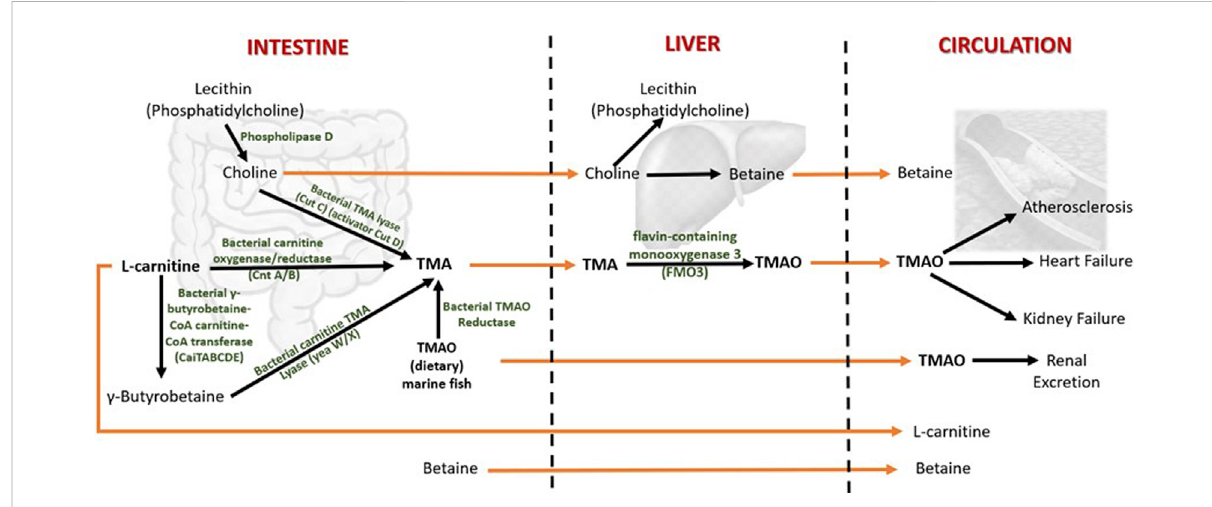
FIGURE 2 Metabolism of TMAO and betaine in humans. Both TMAO and betaine are procured from the diet and synthesized endogenously from the dietary constituents. The gut microbiota plays a central role in TMAO biosynthesis and thereby contributes signi fi cantly to plasma TMAO levels. TMA (trimethylamine) is an intermediate of TMAO metabolism. TMAO is eliminated from the body by excreting in the urine. The increased levels of circulating TMAO are found to be associated with several human diseases. The dietary choline is used to synthesize phosphatidylcholine (a phospholipid abundant in cell membranes), acetylcholine (a neurotransmitter), and betaine (a methyl donor). Betaine is eliminated by metabolism, and urinary excretion is insigni fi